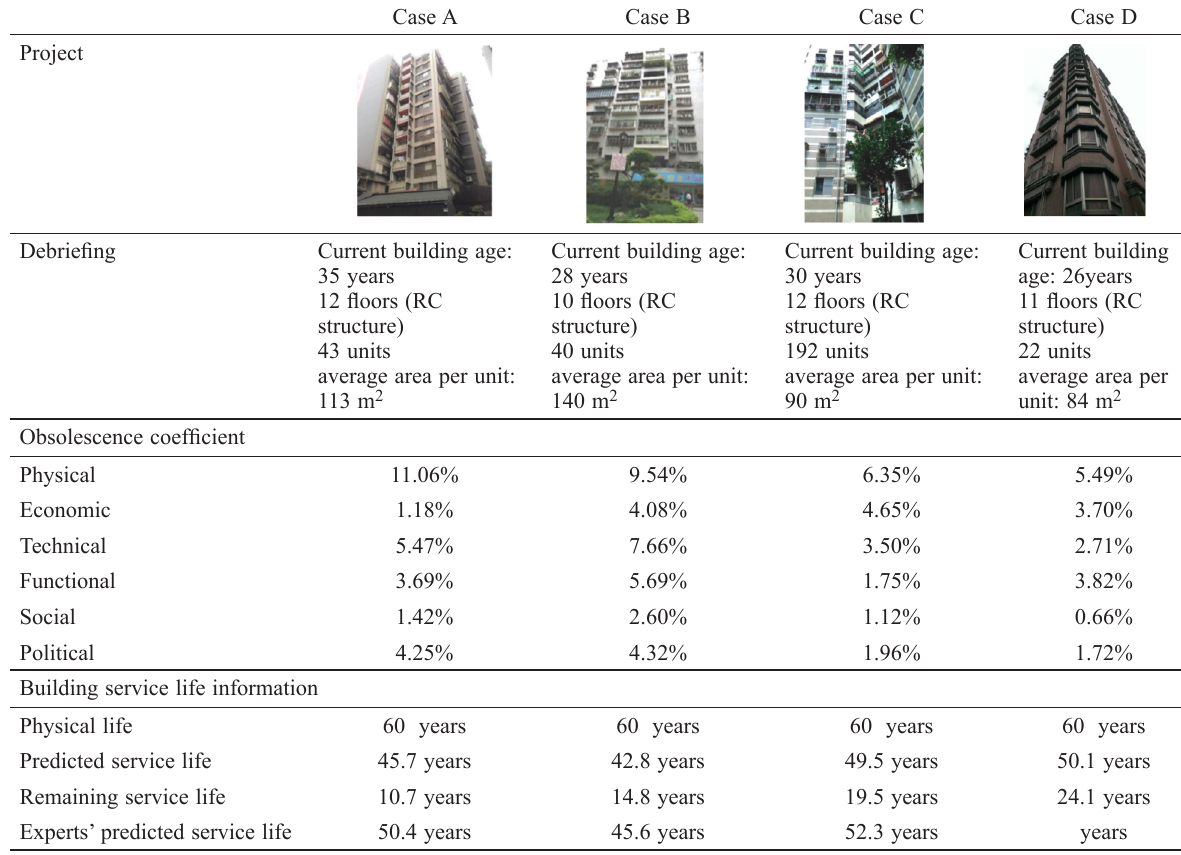
Table 4. Model demonstration of four congregate housing